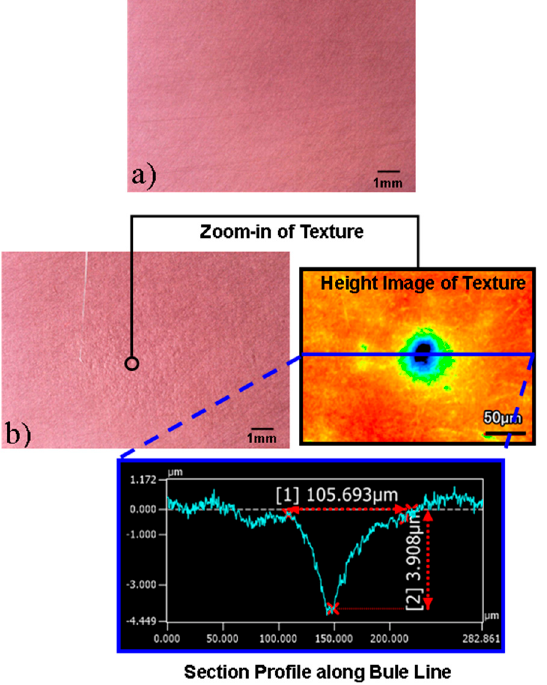
Figure 12. Surface morphology ( a ) before cavitation virgin surface and ( b ) after cavitation.